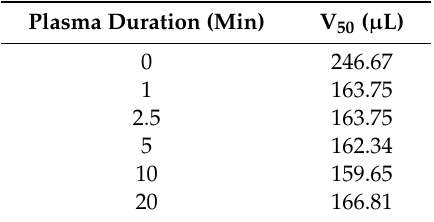
Figure 5. Scanning electron micrographs demonstrate that plasma treatment of PP suture improves microscopic pCD coating uniformity: ( A ) an untreated and pCD-coated PP suture. The pCD coating beads up instead of spreading on untreated PP suture; ( B ) a 10 min plasma-treated and pCD-coated PP suture. The pCD coating is thin and well-spread on the plasma-treated suture, as made apparent based on the presence of cracks caused by sample drying upon sputtering and imaging.